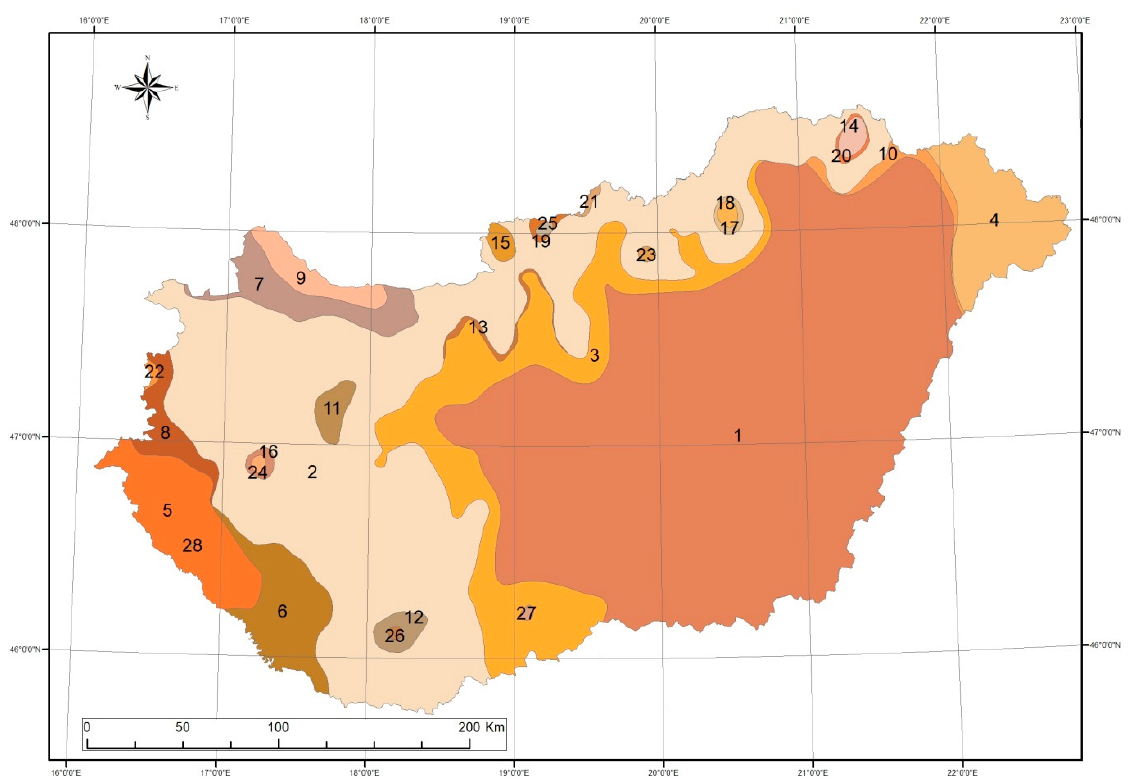
Figure 6. Climate classification based on the Thorntwaite method for the period of 1961–1990 based on CARPATCLIM data. Numbers indicate climate zones.